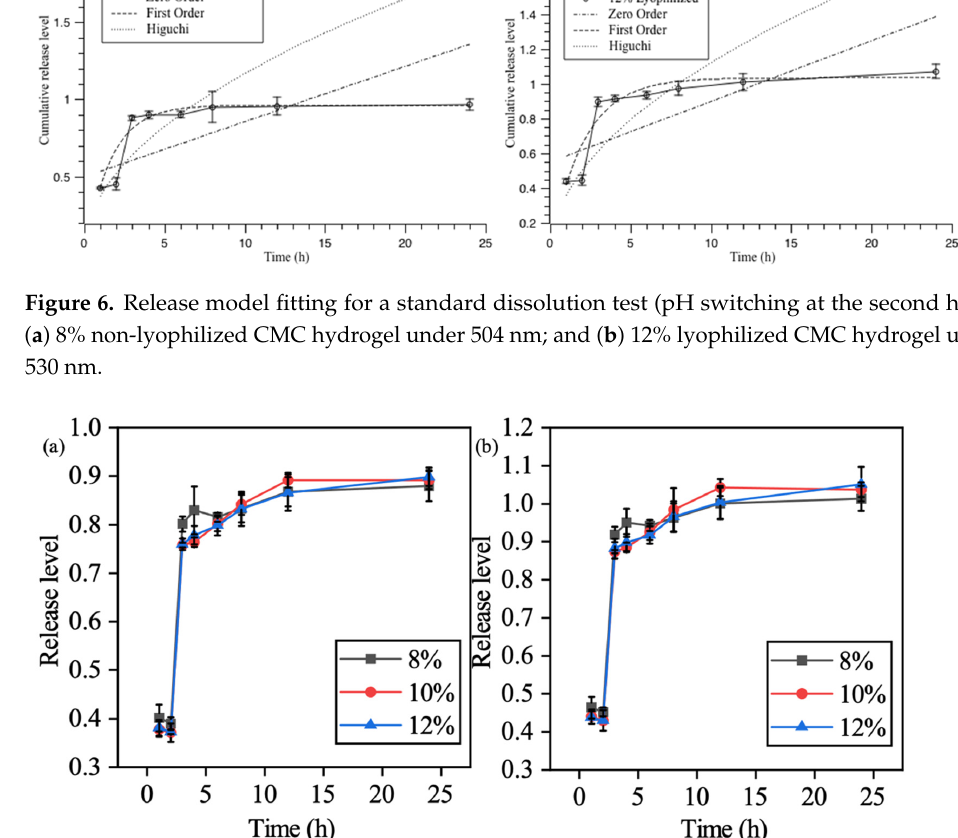
Figure 6. Release model fitting for a standard dissolution test (pH switching at the second hour): ( a ) 8% non-lyophilized CMC hydrogel under 504 nm; and ( b ) 12% lyophilized CMC hydrogel under 530 nm.